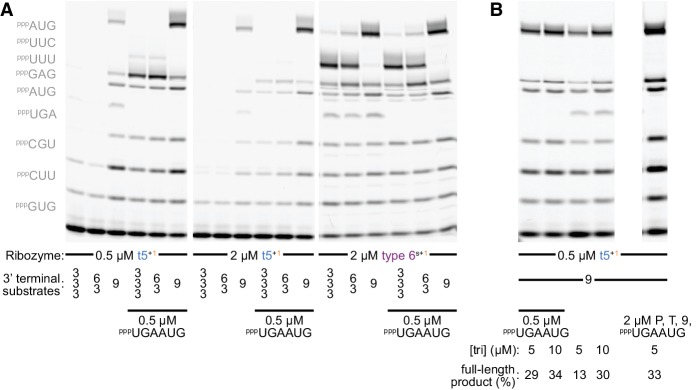
Substrate competition attenuates inhibitory ε+/ε- pairing during self-synthesis.(A) Longer oligonucleotide substrates are required to maximise synthesis of full-length ε+ segment (0.5 µM Fε9 primer/Tε template/oligonucleotide substrate and 5 µM each triplet (left, omitted where equivalent oligonucleotide substrate was present), 13 days in −7˚C ice). Replacing two triplets with a preformed hexanucleotide substrate (pppUGAAUG) boosts full-length ε+ product synthesis by t5+1 (left panel), but not by the type 6s+1 ribozyme - with a different accessory domain (see Figure 2—figure supplement 1, sequence in Supplementary file 1) - which synthesizes ε+ independent of this hexanucleotide (right panel, allowing some full-length ε+ synthesis with only triplets). This likely reflects unfavourable competition between the t5 ribozyme’s own ε+ domain and triplet substrates for complementary pairing to the ε- RNA used as template. Consistent with this hypothesis, increasing t5+1 concentrations with this template is counterproductive (middle panel). For both ribozymes, using a preformed nonanucleotide substrate pppUUUUUCAUG at the end of the template boosted full-length product over use of a pppUUCAUG hexanucleotide +pppUUU triplet, or just the three constituent triplets (S = 9 vs. 6/3 vs. 3/3/3); this is not due to the individual triplet sequences as t5+1 can efficiently incorporate both pppUUU and pppUUC (see Figure 5b, Figure 6a). (B) Doubling triplet concentrations to 10 µM can attenuate t5+1’s requirement for the pppUGAAUG hexanucleotide substrate during ε+ synthesis. This suggests that at higher triplet concentrations they successfully compete with this part of t5 for ε- template hybridisation (0.5 µM Fε9 primer/Tε template/longer oligonucleotide substrates, 13 days in −7˚C ice). With a fourfold excess of primer/template duplex and substrates (right lane), the amount of full-length segment generated exceeds the ribozyme added, evidence of multiple turnover of full-length ε+ product.